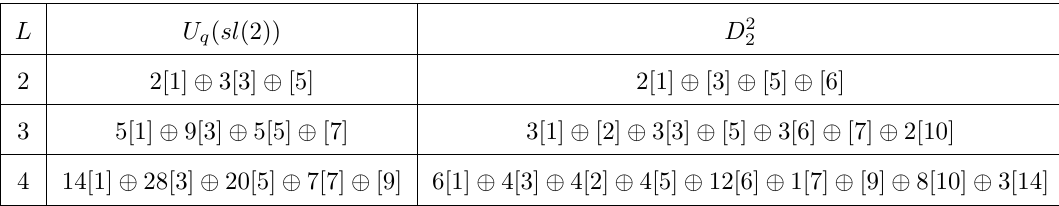
spin chain of length N = 2 L compared with those of the 2